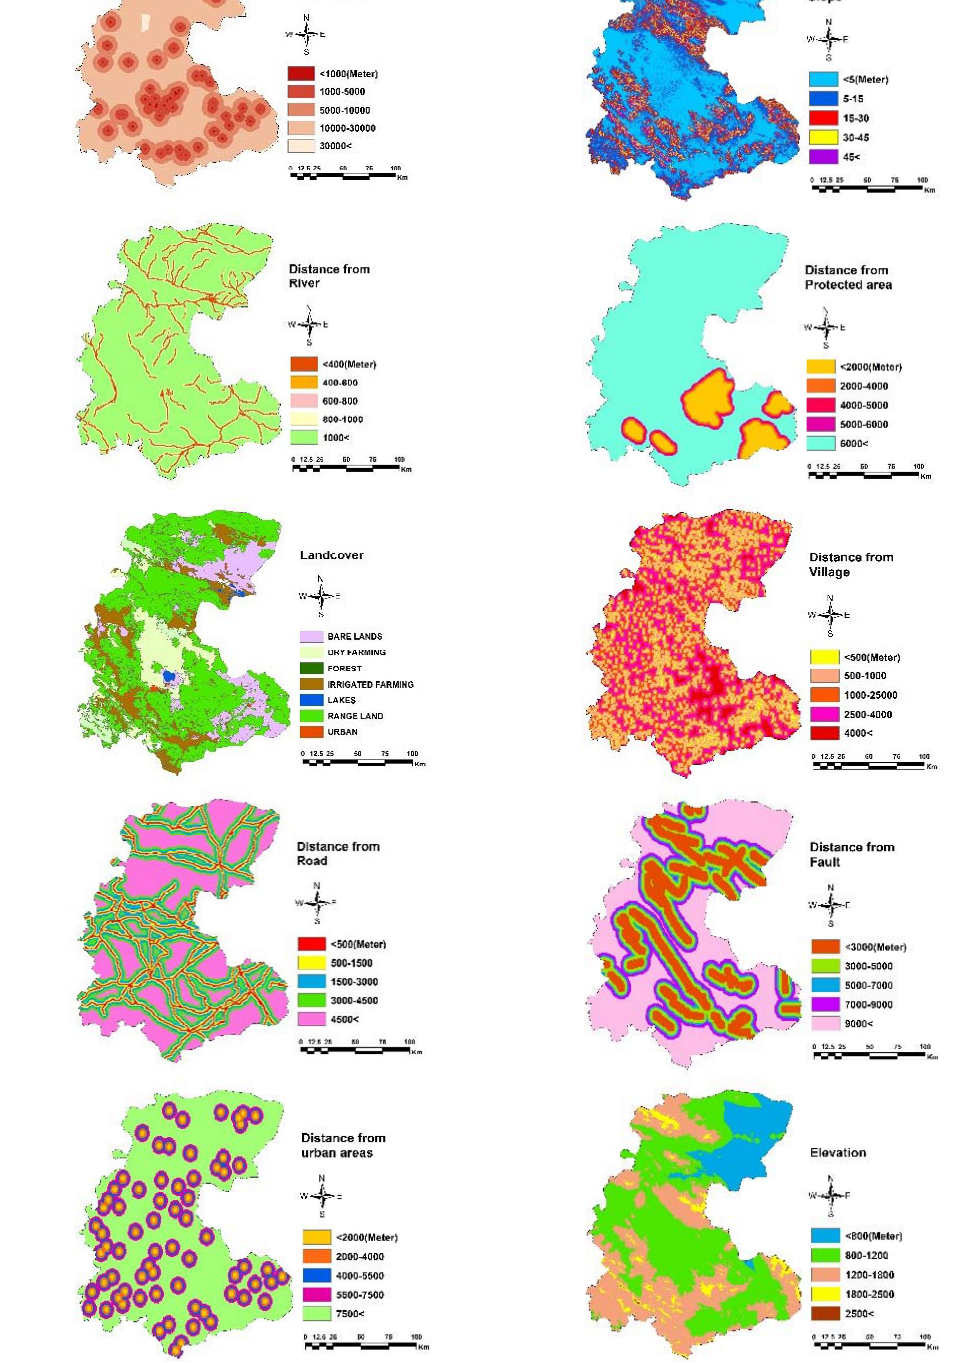
Fig. 6: Input data layers in industrial plants site selection in Markazi province